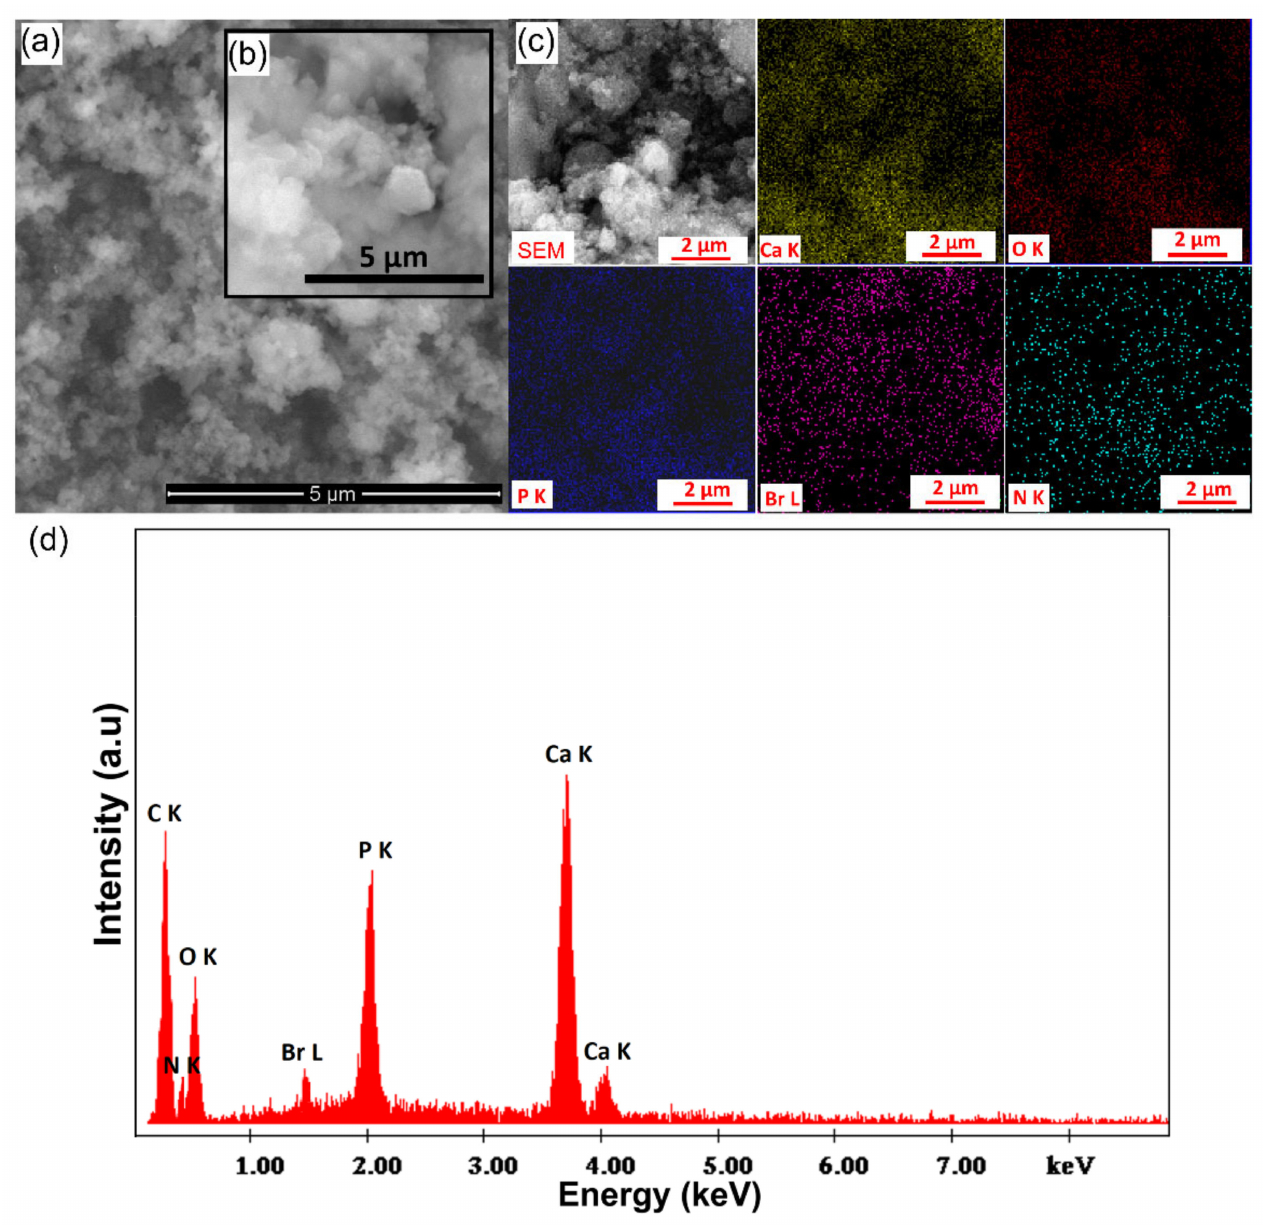
Figure 3. Scanning electron microscopy (SEM) micrograph and zoom area of SEM micrograph ( a , b ), SEM micrographs of elemental distribution and elemental distribution maps ( c ), and energy-dispersive X-ray spectroscopy (EDS) spectra ( d ) of HAp-CTAB